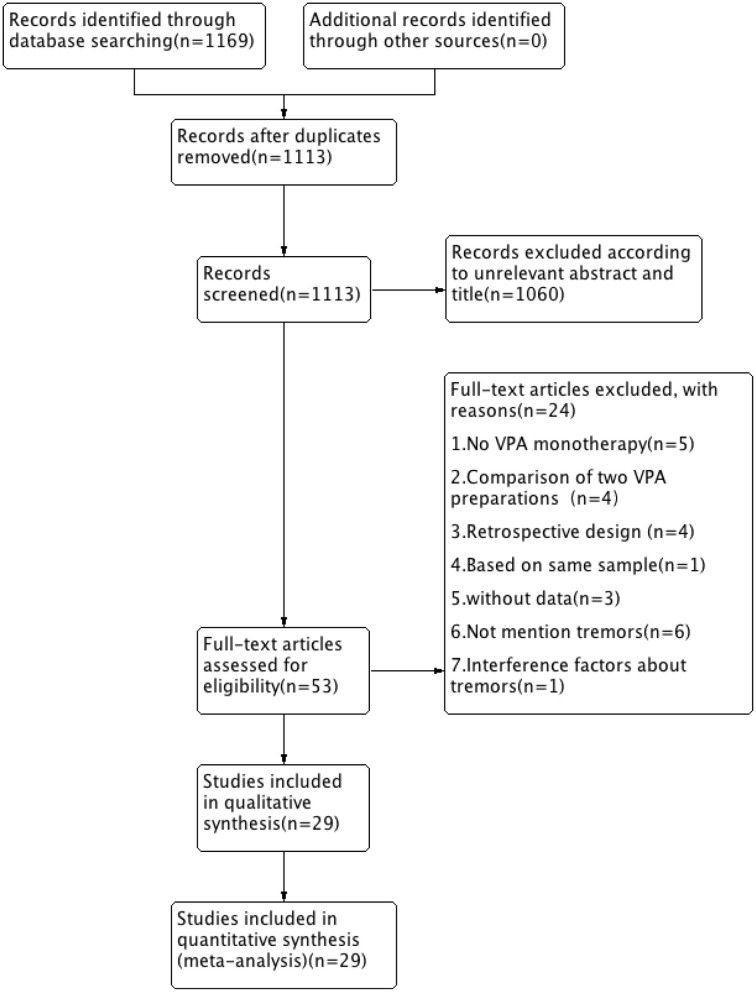
Flow chart of selection of studies about tremor in patients taking VPA therapy. VPA, valproic acid.